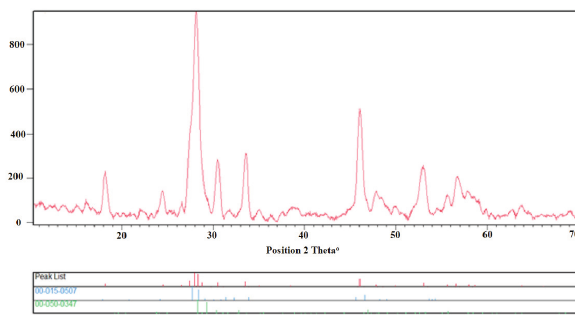
Figure 4: EDAX spectrum of synthesized Sm precipitation method.